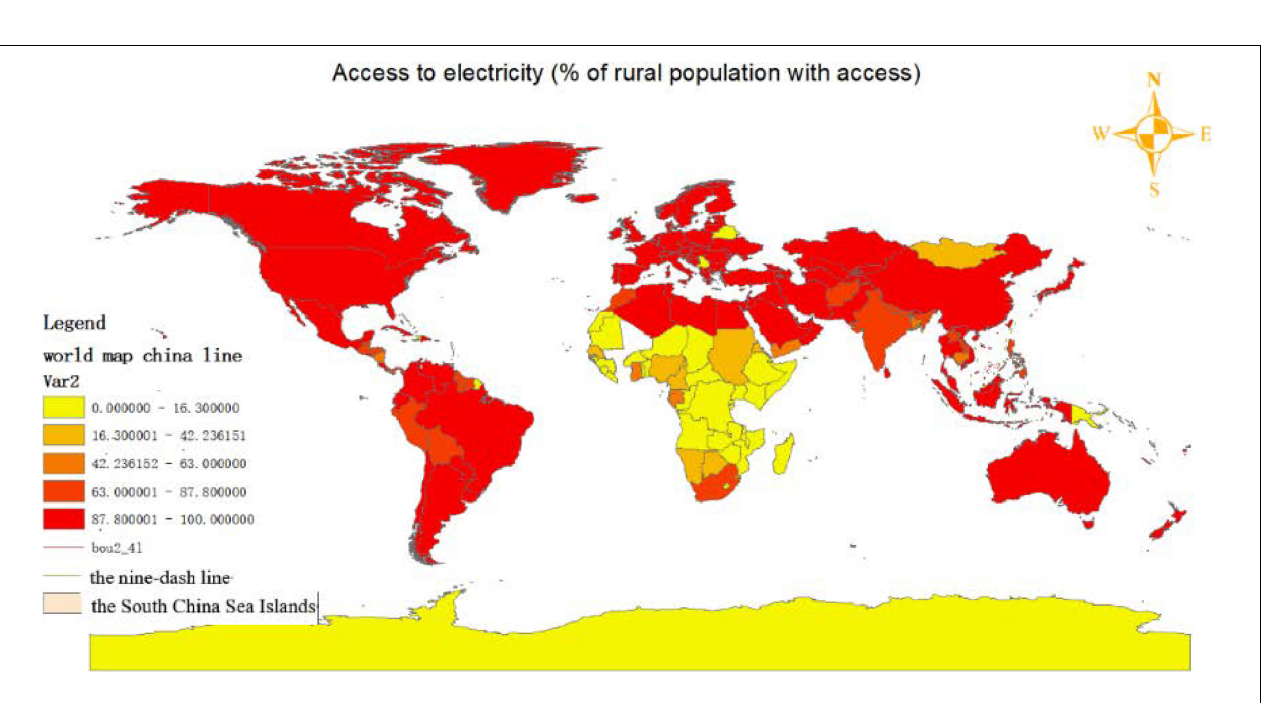
FIGURE 5 | Access to electricity (% of rural population with